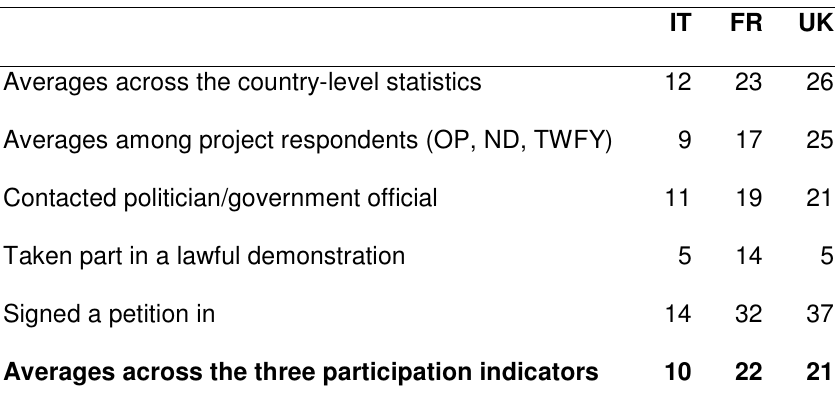
Table 4. Respondents with health problems and disabilities engaged in alternative forms of participation (Authors’ surveys 2011; Escher 2011; ESS1-2002 11 ) IT FR UK Averages across the country-level statistics 12 23 26 Averages among project respondents (OP, ND, TWFY) 9 17 25 Contacted politician/government official 11 19 21 Taken part in a lawful demonstration 5 14 Signed a petition in 14 32 37 Averages across the three participation indicators 10 22